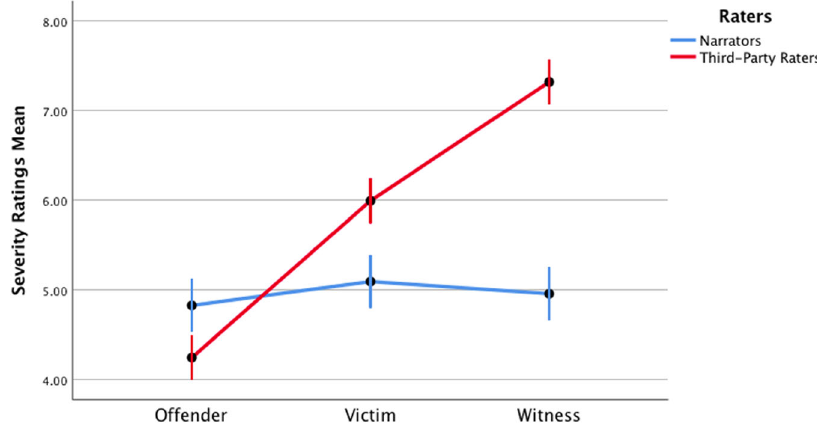
Fig. 1 Mean severity physical violence ratings of recipients minus narrators. The fi gure shows the mean severity ratings for offenders, victims and witnesses divided into narrators and recipients.